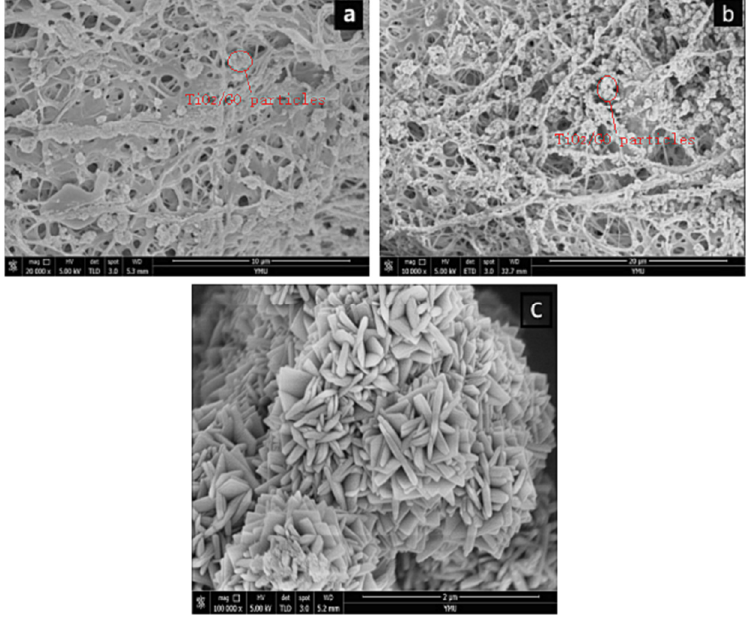
Figure 4. SEM images of PLLA/CS–GO/TiO 2 after ( a ) 10 min and ( b ) 30 min of loading; ( c ) SEM image of TiO 2 particles on fiber surface.